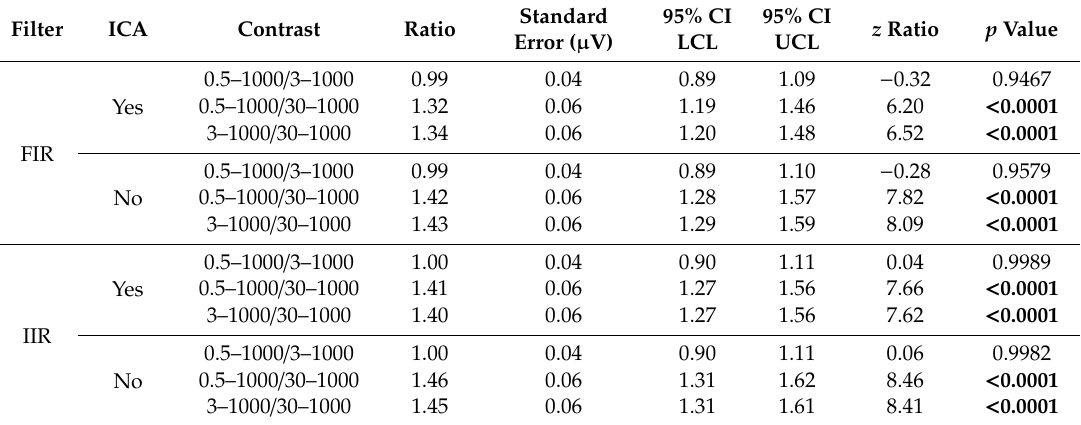
Table 5. Estimated contrasts of frequency bands (Hz) (0.5–1000 / 3–1000, 0.5–1000 / 30–1000 and 3–1000 / 30–1000). Significant e ff ects ( p < 0.05) are in bold text.